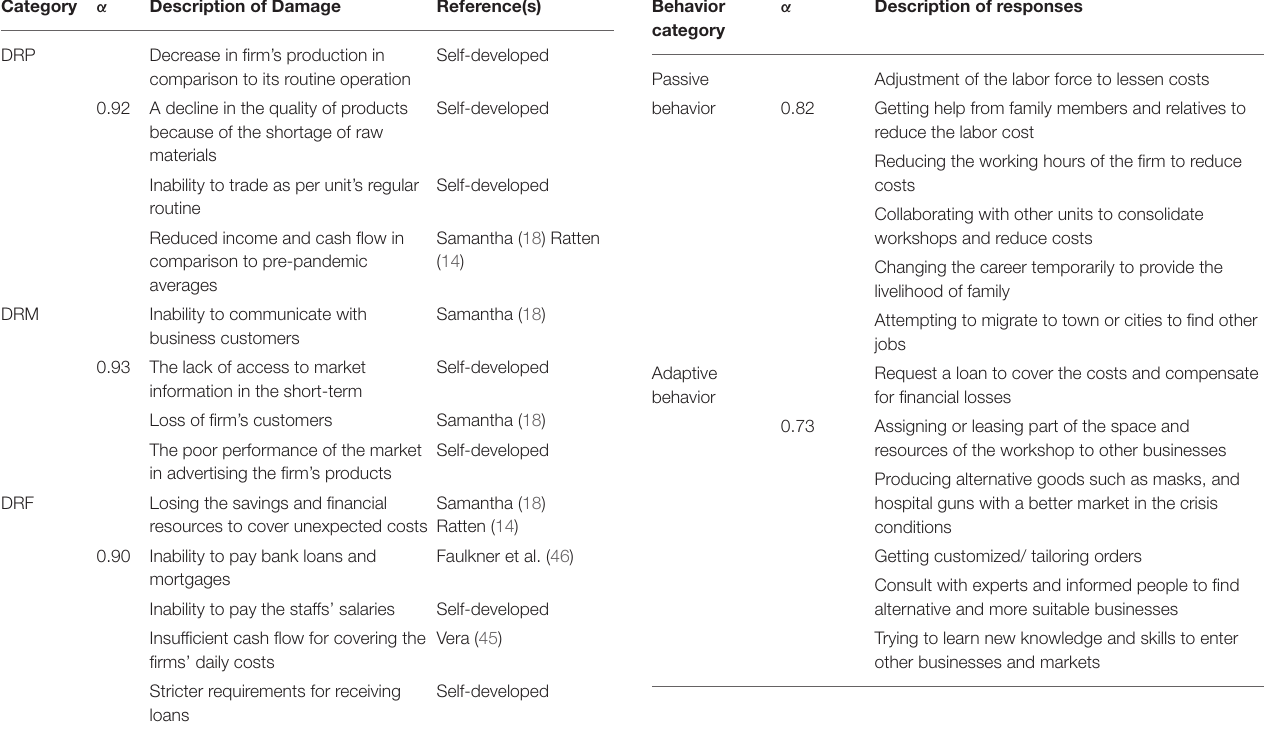
TABLE 1 | Description of different types of damages of MSEs in the COVID-19 pandemic. Category α